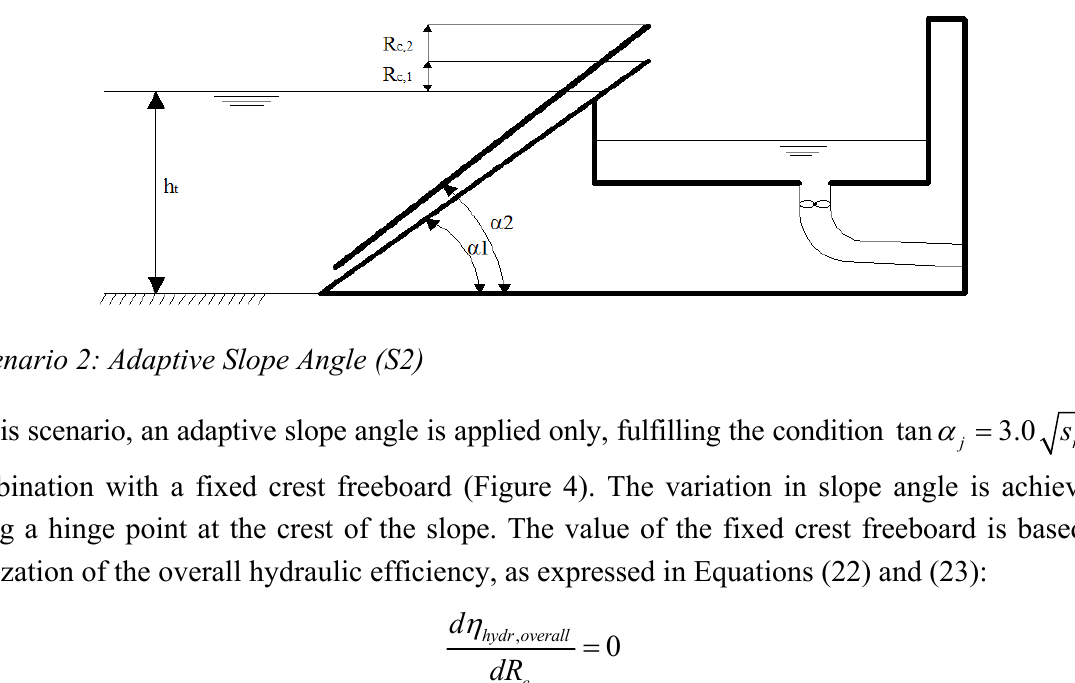
Figure 3. Scenario 1—Geometry control by adaptive slope angle and adaptive crest freeboard